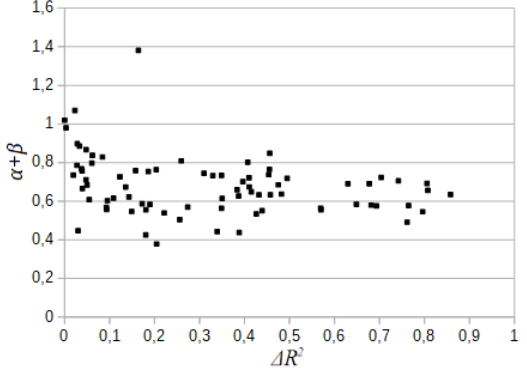
Fig. 8. Dependence of the returns to scale of model (1) on ΔR 2 for (6a) and